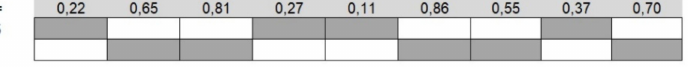
Figure 3. The uniform crossover.